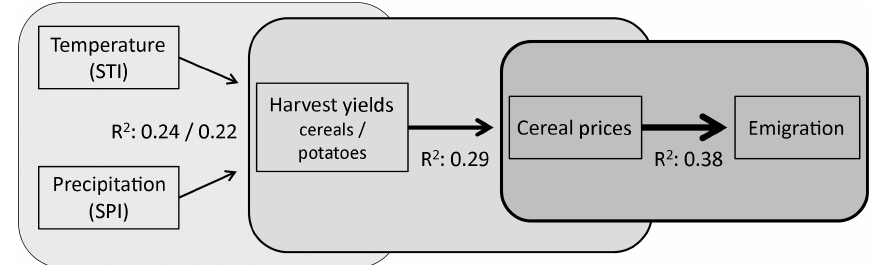
Figure 11. Chain of effects on emigration in the kingdom of Württemberg with corresponding coefficients of